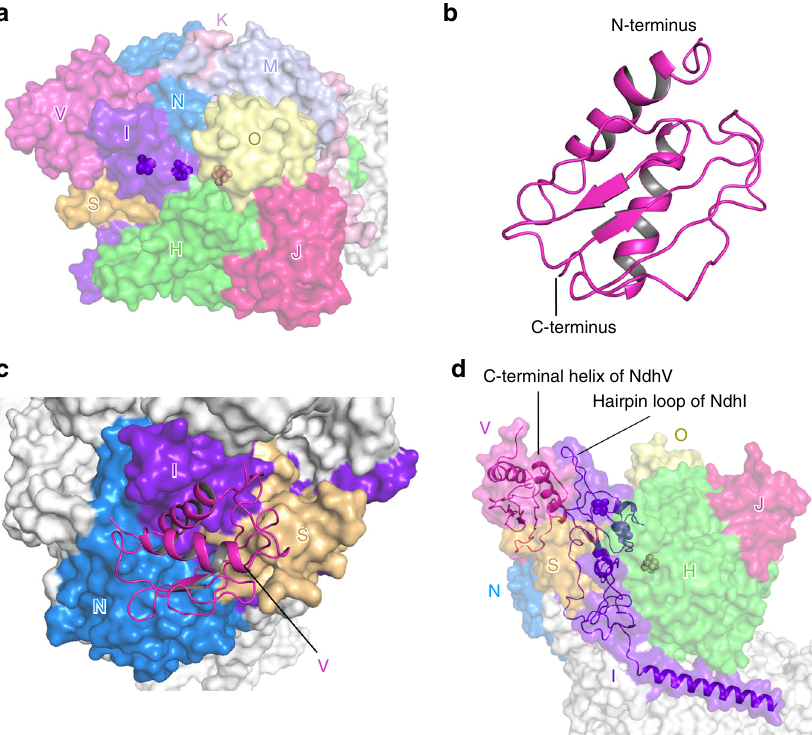
Fig. 3 The hydrophilic arm containing NdhV. a The location of subunits in the hydrophilic domain. The nine NDH subunits in the hydrophilic domain are colored differently and labeled with the abbreviations of one letter (for example, letter V indicates subunit NdhV). The 4Fe – 4S clusters are shown as spheres. b Overall structure of NdhV. c The binding position of NdhV. NdhV is shown in cartoon, other subunits are shown in surface mode. NdhI, NdhS, and NdhN are colored differently and labeled, whereas other subunits are shown in white. d The C-terminal helix of NdhV interacts with the hairpin loop of